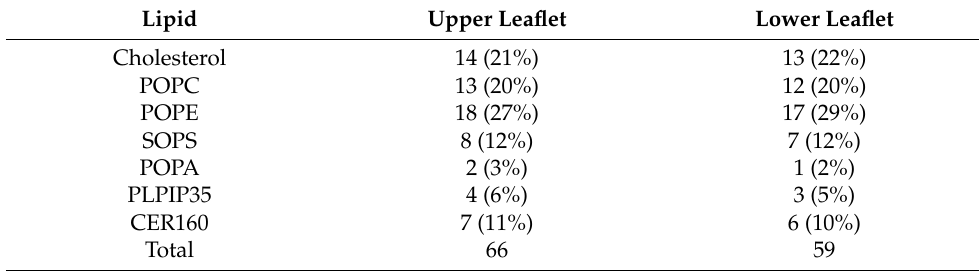
Table 1. Membrane composition for δ C1b-phorbol